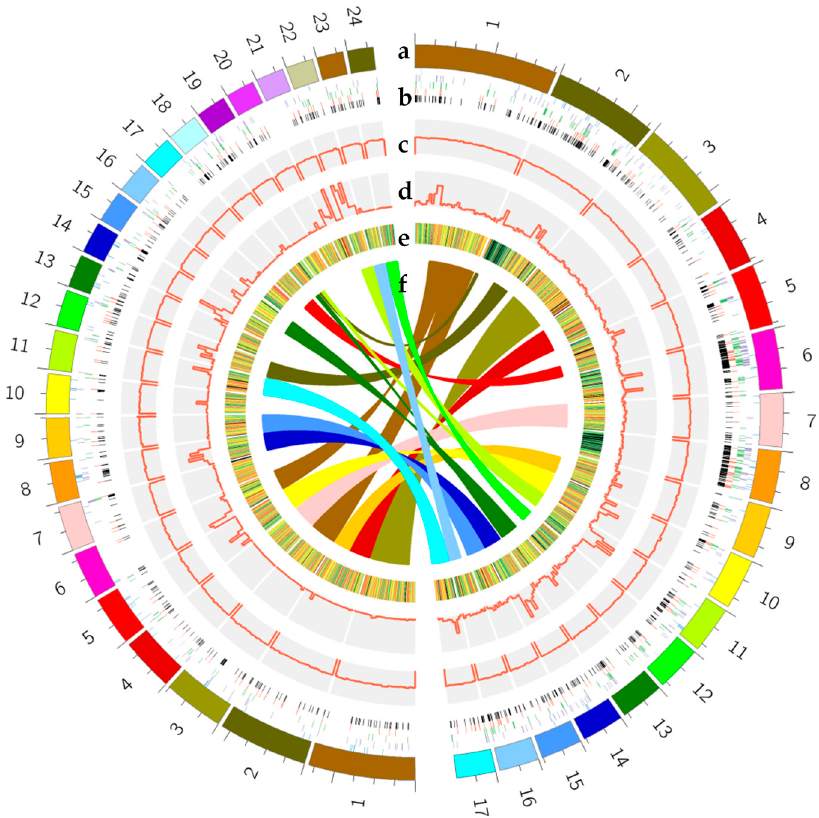
Figure 1. Genomic comparison and characteristic analysis of the two opposite-polarity monospore strains of Morchella importuna . Genomic comparison and characteristic analysis of the top N50 sequences between the two monospore strains, M04M24 and M04M26. The outermost loop is the scaffold fragment of the two strains, with different scaffolds indicated in different colors; M04M24 is on the right, M04M26 is on the left. The scaffolds that were larger than the respective N50 values are numbered 1 to 17 for M04M26, and from 1 to 24 for M04M24. The innermost circle ( f ) is the gene collinearity between the two strain scaffolds of the outermost ring ( a ), and the inner color corresponds to the outer color of the scaffold. ( b ) shows the distribution of the four different types of repeat sequences in the genome, and from outside to inside are the three RNA repeat sequences: long terminal repeat (LTR) green lines, long interspersed nuclear element (LINE) purple lines, short interspersed nuclear element (SINE) blue lines, and DNA repeat sequences: red lines, with black lines in the innermost cycle displayed as the synthesis of four repeat sequences. ( c ) (the histogram) represents the percentage of GC in the genome. ( d ) shows the single-nucleotide polymorphism (SNP) frequency of the genome in the form of a histogram, and the ordinate is the SNP number per 20 kb of genome. ( e ) shows the gene expression of RNA sequencing (RNA-seq) samples in the form of heat map. Red indicates that FPKM (Fragments Per Kilobase Million) is more than 100, orange is 100 > FPKM > 10, green is 10 > FPKM > 0, and black indicates FPKM = 0.